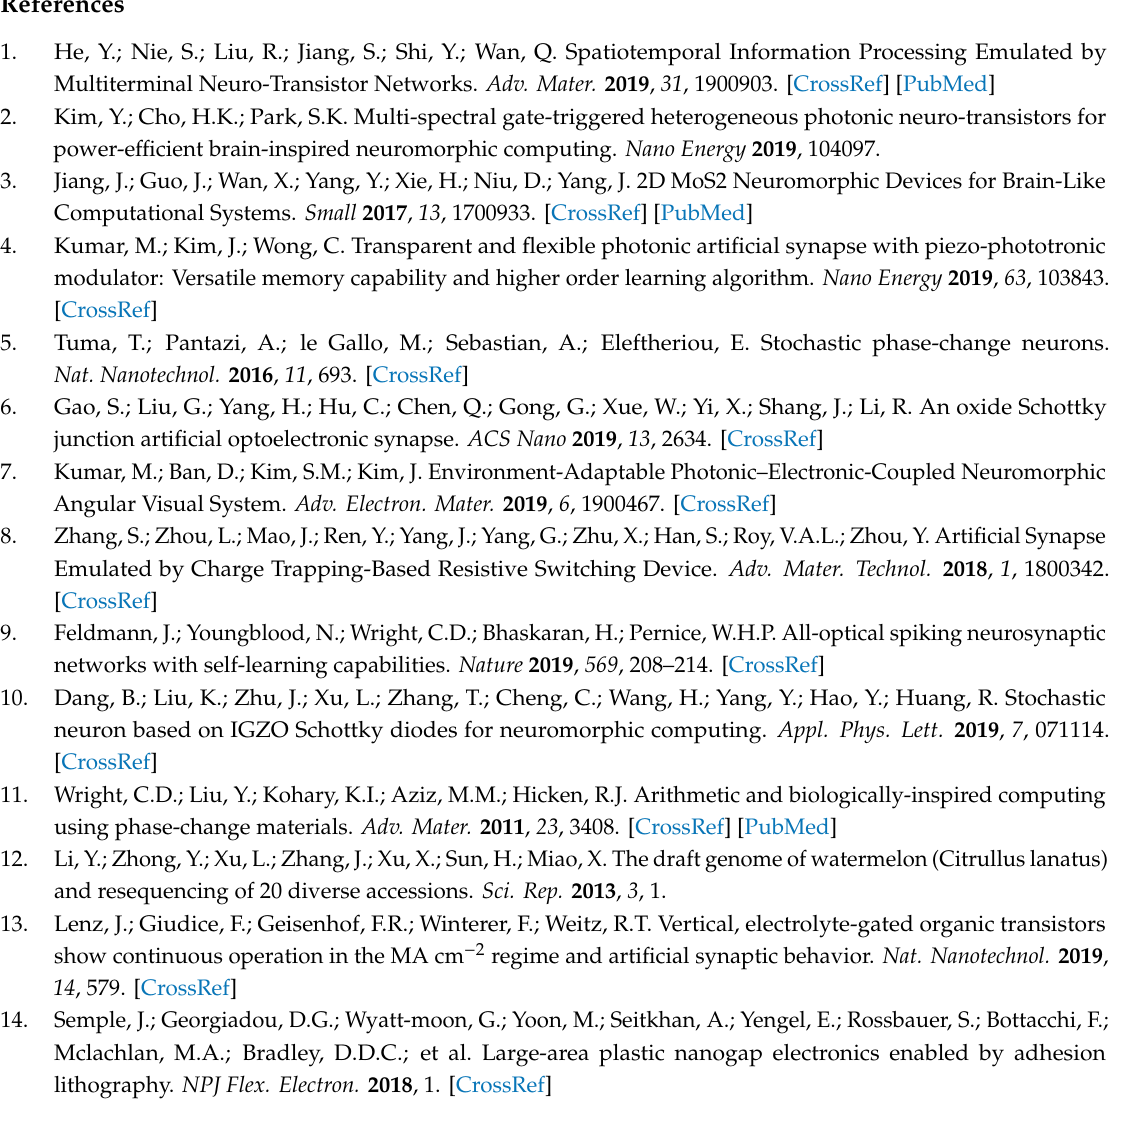
s1, Figure S1: ( a ) The geometrical di ff erences between nanowire and nanofin. ( b ) Cross-sectional device schematics. ( c ) Sequential steps of the device fabrication, Figure S2: ( a ) Growth of circular and line pattered electrodes. ( b ) Original phots of circular nanofin. The blue disc is the failure of the device fabrication. ( c ) Schematic of the circular nanofin. ( d ) Line patterns used to grow vertical nanofin of di ff erent length and width. ( e ) Schematic of vertically grown nanofin, Figure S3: XPS spectra of ( a ) Zn and ( b ) oxygen after and before the UV illumination,